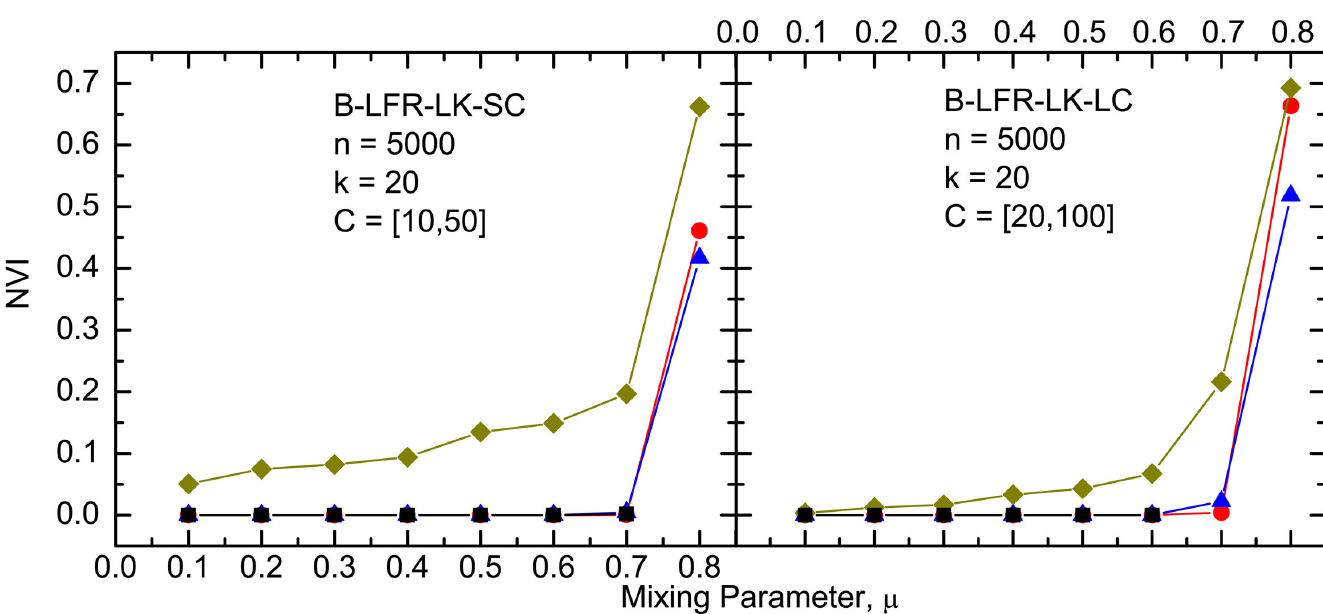
Fig 8. The NVI comparison on undirected and unweighted big LFR benchmark networks with large average degree. The legend is the same as in Fig 7.